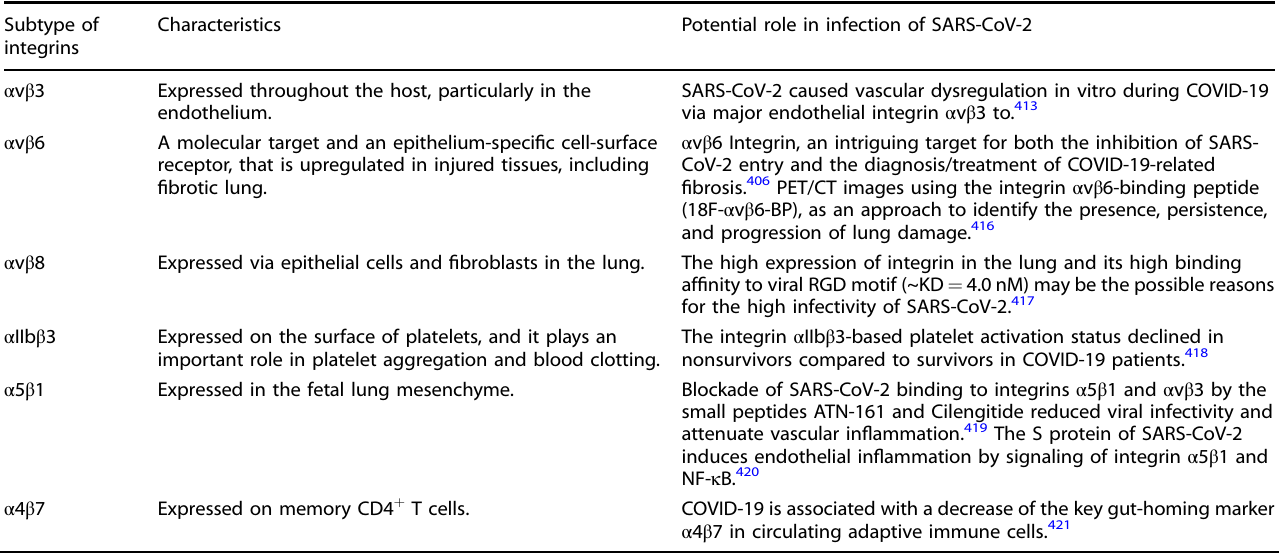
Table 1. Integrins expression involved with SARS ‐ CoV ‐ 2 infection Subtype of